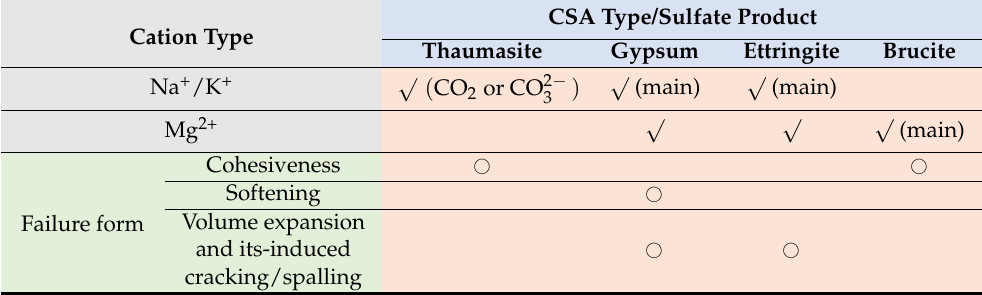
Table 2. Relationship among cation type of sulfate solution, CSA classification, and failure forms.